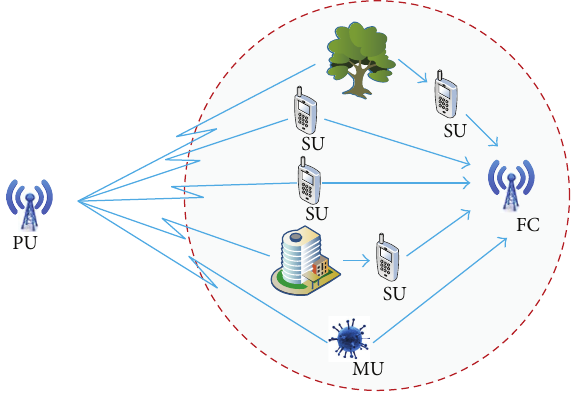
Figure 1: Cooperative users in a CR